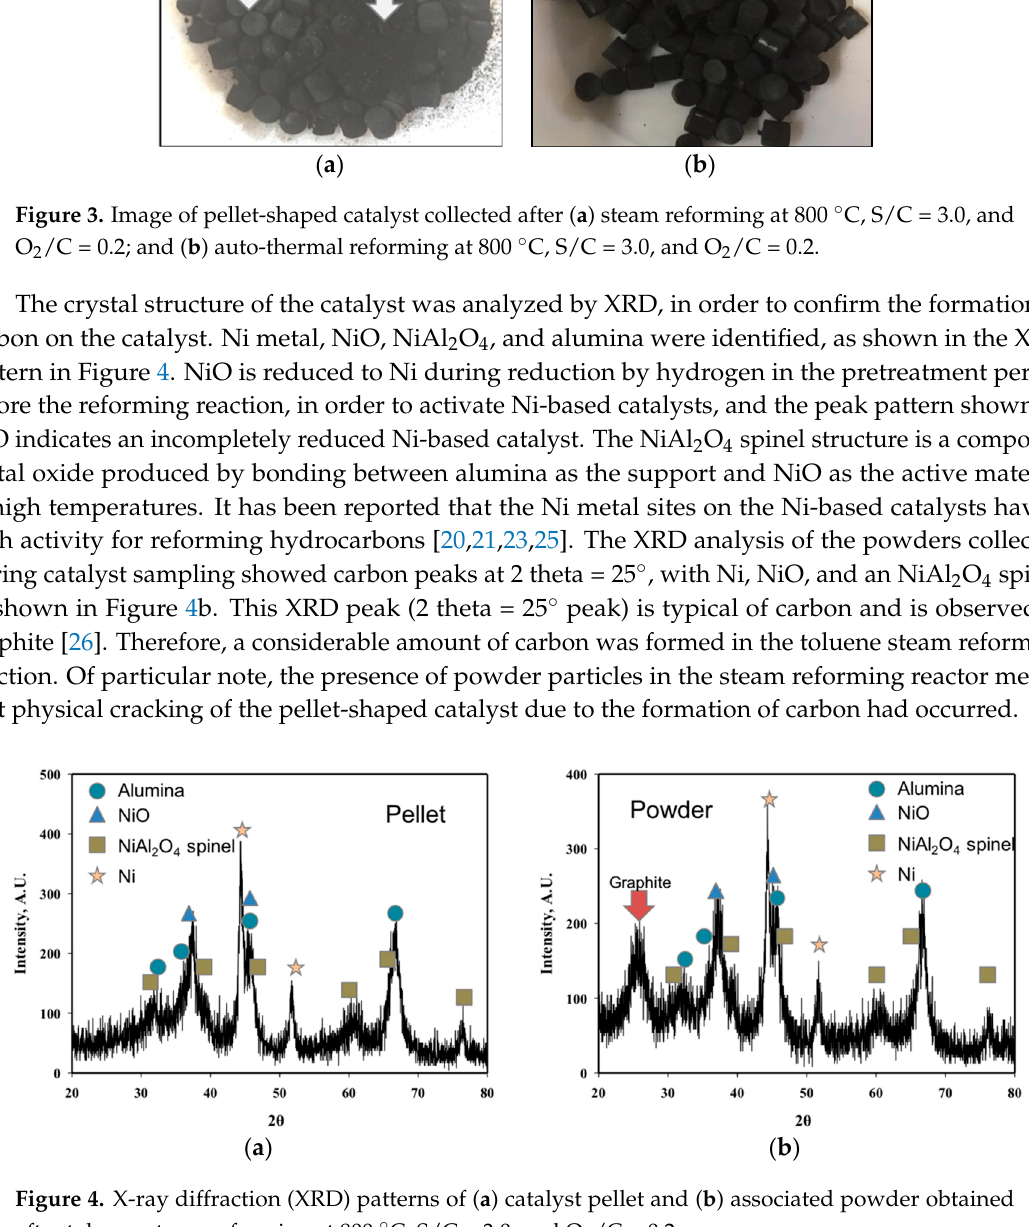
Figure 4. X-ray diffraction (XRD) patterns of ( a ) catalyst pellet and ( b ) associated powder obtained after toluene steam reforming at 800 °C, S/C = 3.0, and O 2 /C = 0.2.